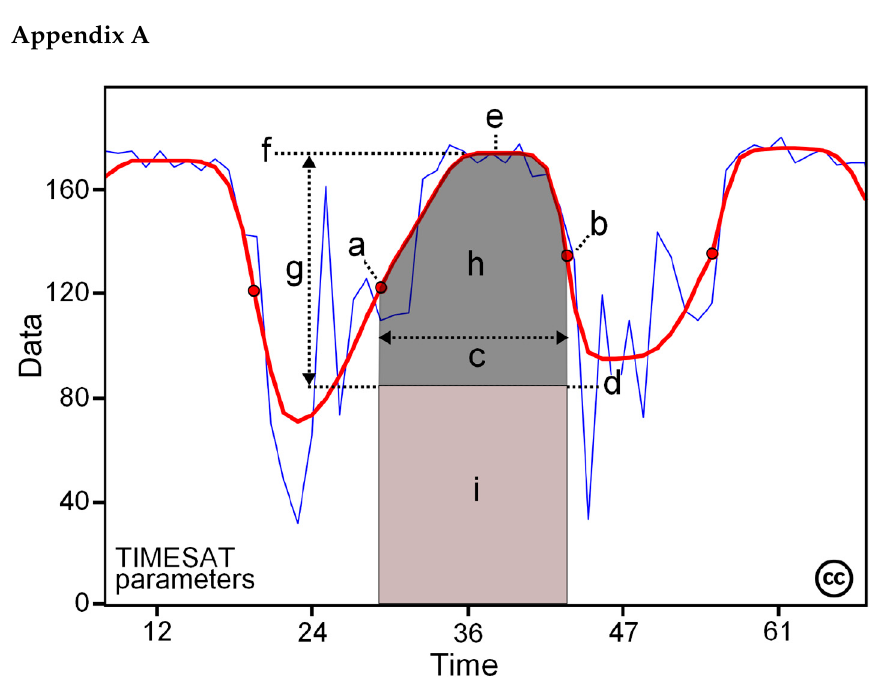
Figure A1. Some of the seasonality parameters generated in TIMESAT [24]: (a) beginning of season, (b) end of season, (c) length of season, (d) base value, (e) time of middle of season, (f) maximum value, (g) amplitude, and (h) small integrated value, (h + i) large integrated value. Raw time-series values are represented by the blue curve and the fitted time-series by the red curve. This figure is